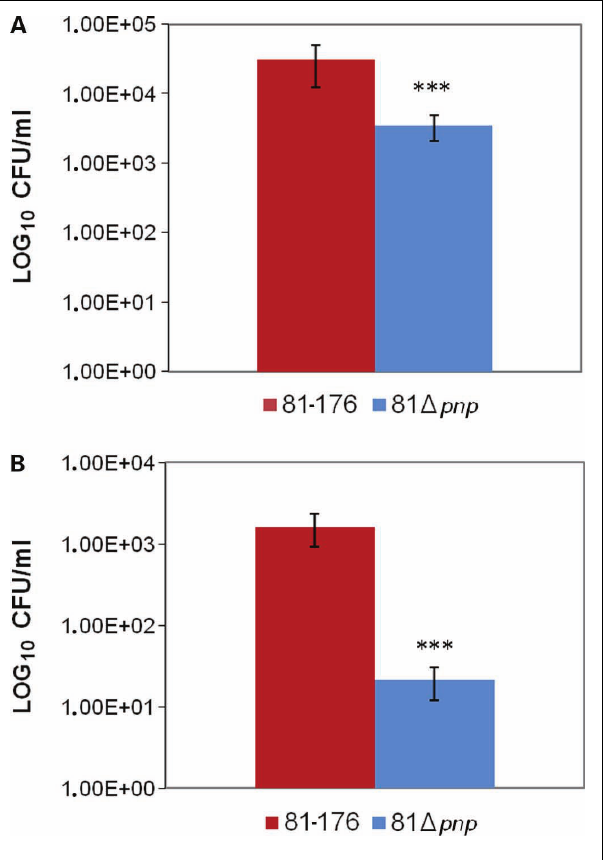
FIGURE 4 |Adhesion and invasion of C. jejuni in Ht-29 cells. (A) Effect of mutation of the pnp locus on C. jejuni adhesion to Ht-29 human intestinal epithelial cells. (B) Ht-29 cell invasion assay. Cells were infected with the parental and mutant strains for 3 h, and invasion values were calculated from the number of bacteria that survived 2 h of incubation in the presence of gentamicin.The experiment was performed in duplicate from at least three independent cultures.The values plotted represent means ± standard deviations (error bars). Statistical significance was assessed with an unpaired Student’s t -test. *** P <